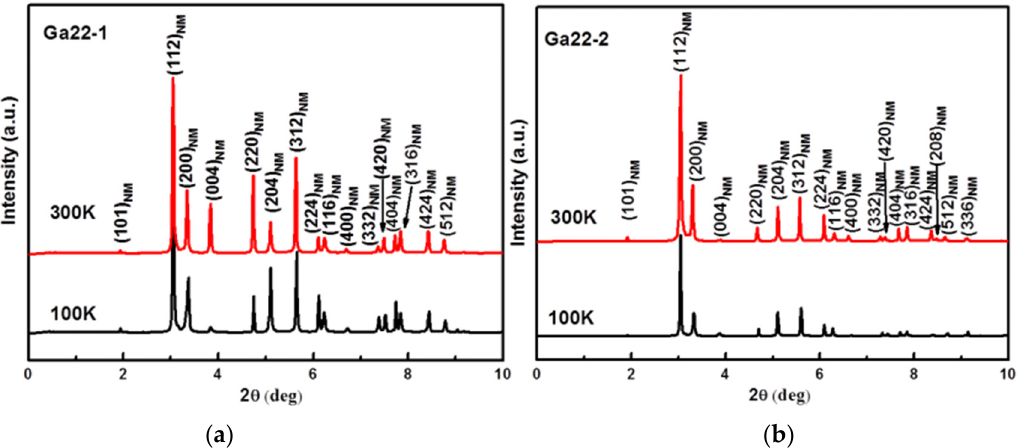
Table 1. Lattice parameters of Ga22-1 ( x = 0) and Ga22-2 ( x = 2) alloys at 300 K and 100 K.